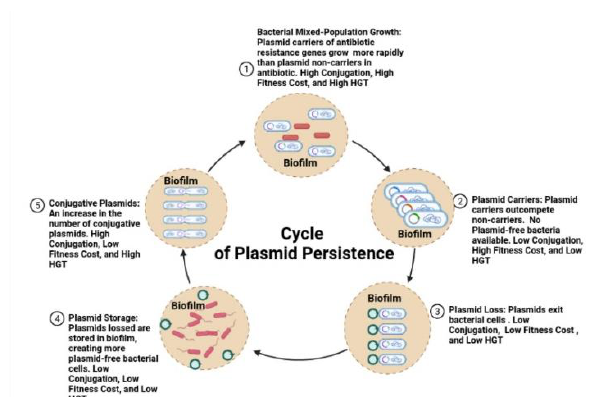
Figure 6 : An integrative and Hypothetical Model for the Cycle of Plasmid Persistence. This hypothetical model shows a cycle for plasmid persistence in natural bacterial populations within communities of biofilm formed on abiotic or biotic surfaces. These bacterial communities begin growing with host cell plasmid carriers and non-carriers. The plasmid carriers grow more vigorously than the non-carriers until there are no plasmid-free bacteria available. At this point, there is a high fitness cost with low conjugation and low horizontal gene transfer (HGT). The plasmid carriers then begin losing plasmids at a high rate, and then the plasmids are stored in the biofilm. This generates more plasmid-free cells where the plasmids can then enter the cells. The level of conjugation heightens with a low fitness cost and a higher rate of HGT. Bacterial cells re-enter a state of growth to restart the cycle of plasmid